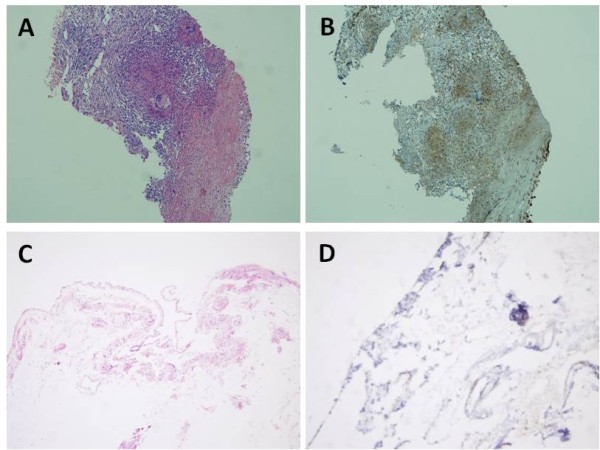
The expression of S100A4 in pleural tissue. (A) HE stained of tuberculous pleurisy (10 × 10). (B) S100A4 protein expression in tuberculous pleurisy in cell cytoplasm and nucleus, stained by S-P method (10 × 10). The S100A4 positive cells are brown. (C) HE stained of normal pleural tissue (10 × 10). (D) No brown cells were observed. S100A4 protein is not expressed in normal pleural tissues, stained by S-P method (10 × 10).